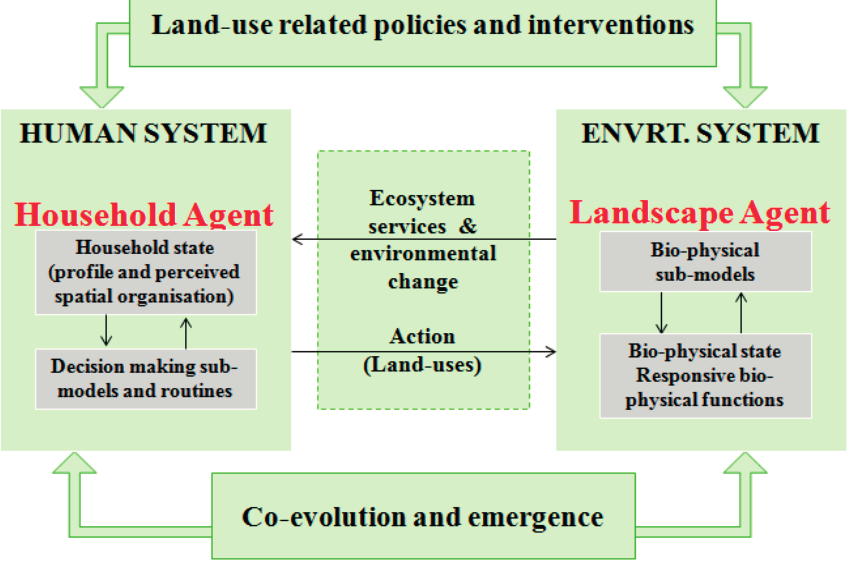
Figure 2. Vea-LUDAS framework. Adapted from